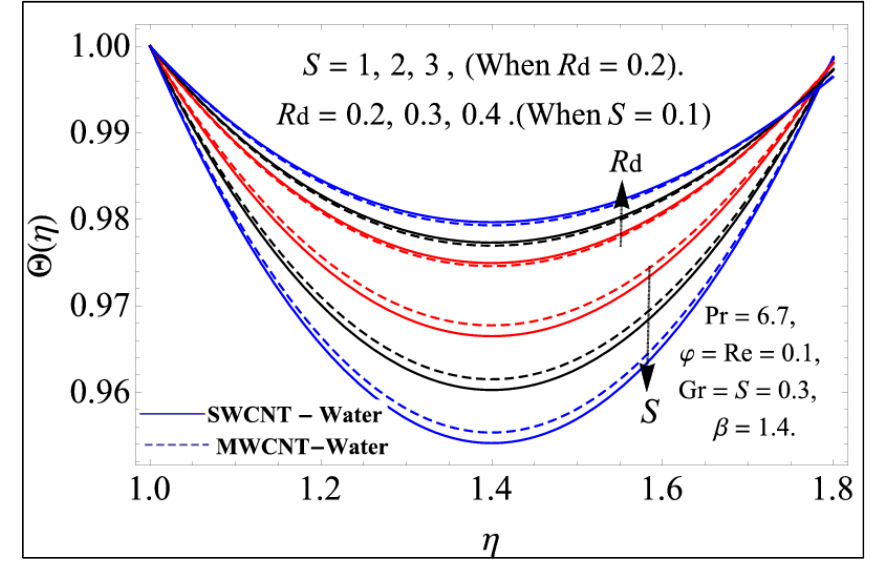
Figure 9. Impact of the S & Rd on the temperature field.